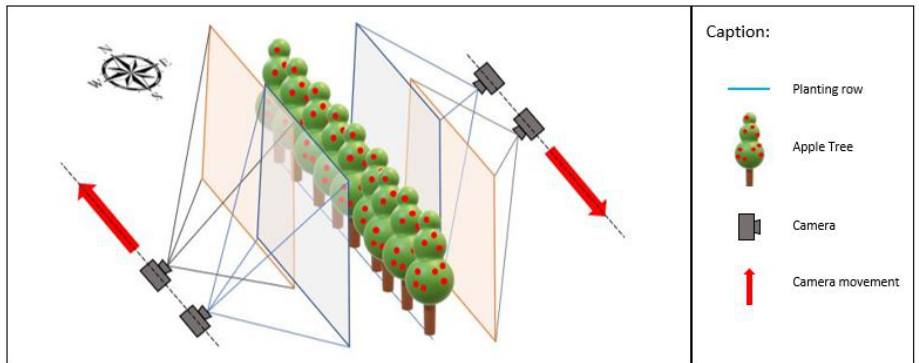
Figure 2. Graphic scheme of obtaining the images in the Orchard. Overlapping the ground pictures are also